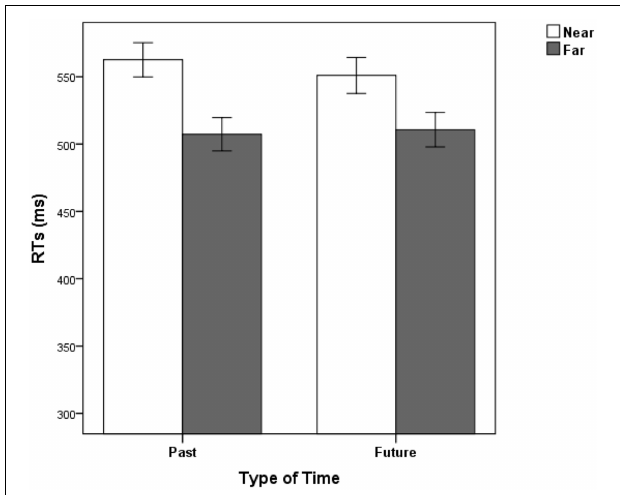
FIGURE 3 | Mean RTs in Experiment 3 as a function of type of time and distance. Error bars represent standard errors of the